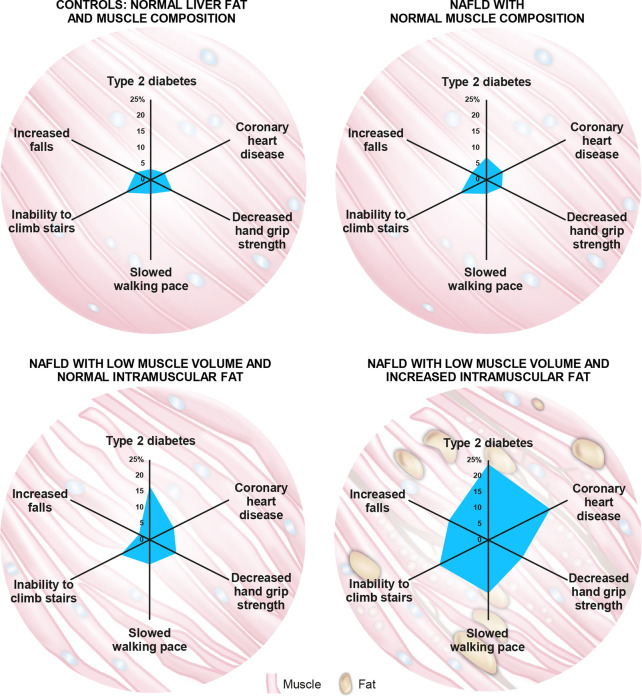
The role of muscle composition in non-alcoholic fatty liver disease (NAFLD) and related comorbidities. A recent analysis of the UK-BioBank (UKBB) resource by Linge et al (69). revealed that participants with NAFLD and normal muscle composition had generally similar metabolic and functional characteristics to those with normal liver and muscle composition. Interestingly, participants with NAFLD combined with adverse muscle composition (AMC), defined as the presence of both low muscle volume (i.e., <25th percentile of the UKBB population) and high muscle fat infiltration (i.e., >75th percentile of the UKBB population), exhibited a larger “footprint” (higher prevalence) of relevant comorbidities and functional impairment when compared with the other groups evaluated. Numbers on axes represent prevalence (%) of each indicated comorbidity/functional impairment.